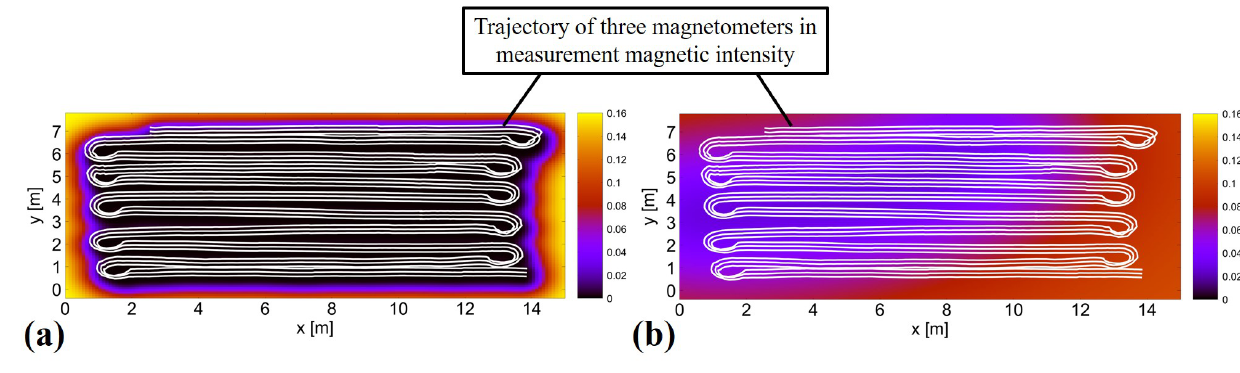
Figure 11. Color map of the variance stored in REAL’s magnetic map. ( a ) using GPR, ( b ) using SGPR with five inducing variable points. The white lines represent the trajectories of the three magnetic sensors mounted on the robot during the acquisition of magnetic